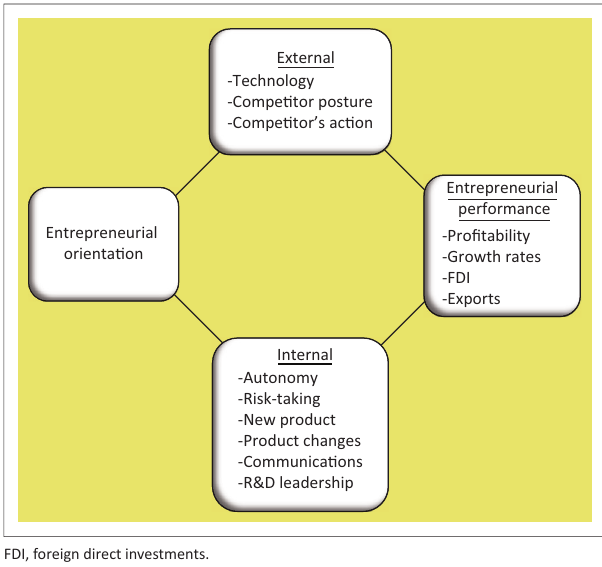
FIGURE 1: Entrepreneurial